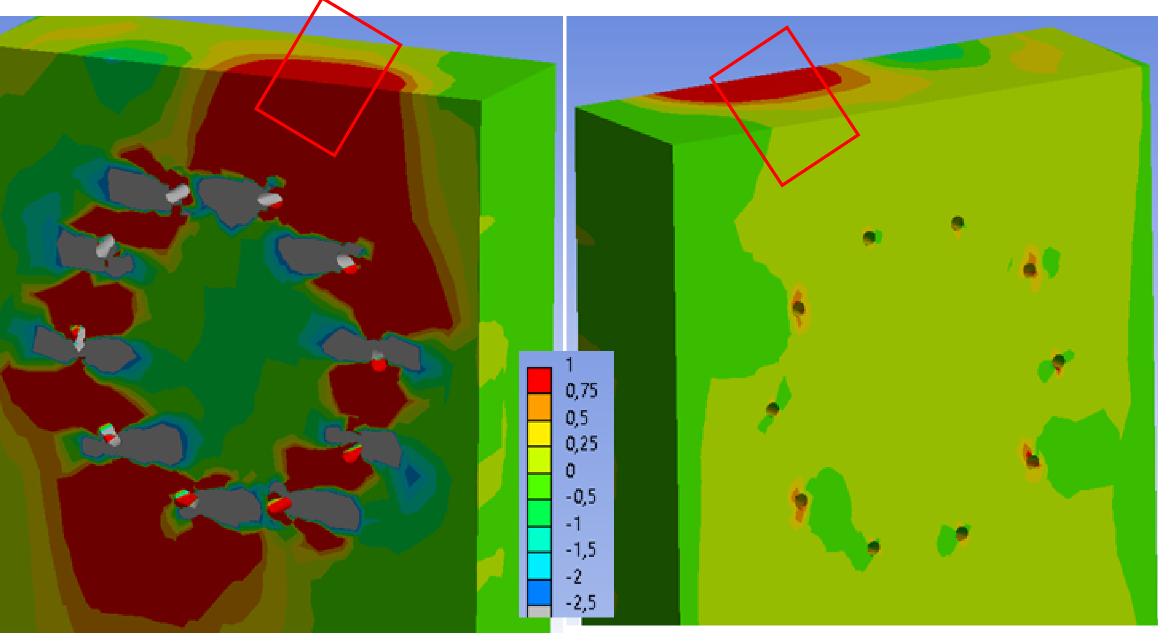
Table 9. Results of numerical modeling, Experiment B.